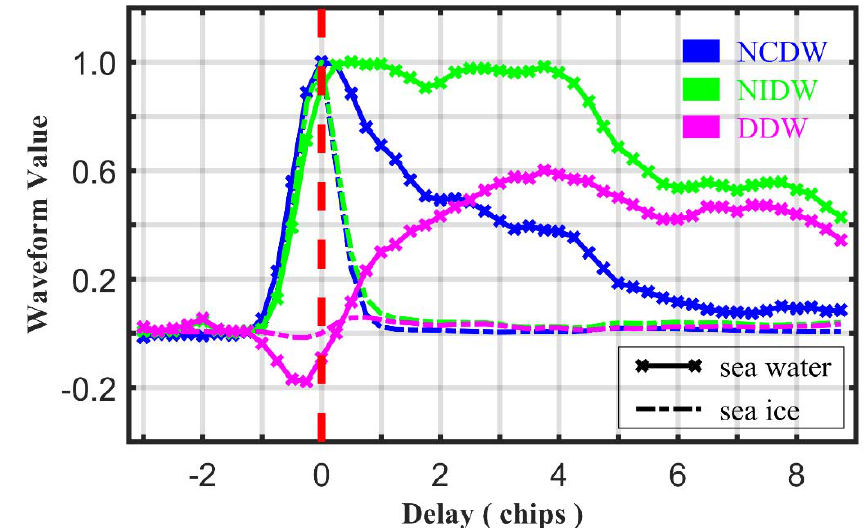
Figure 3. Delay waveforms of sea water (cross line) and sea ice (dotted line). The NCDW, NIDW and DDW are plotted in blue, green and magenta, respectively. The waveforms are divided into the left edge (LE) and right edge (RE) by the red dashed line.